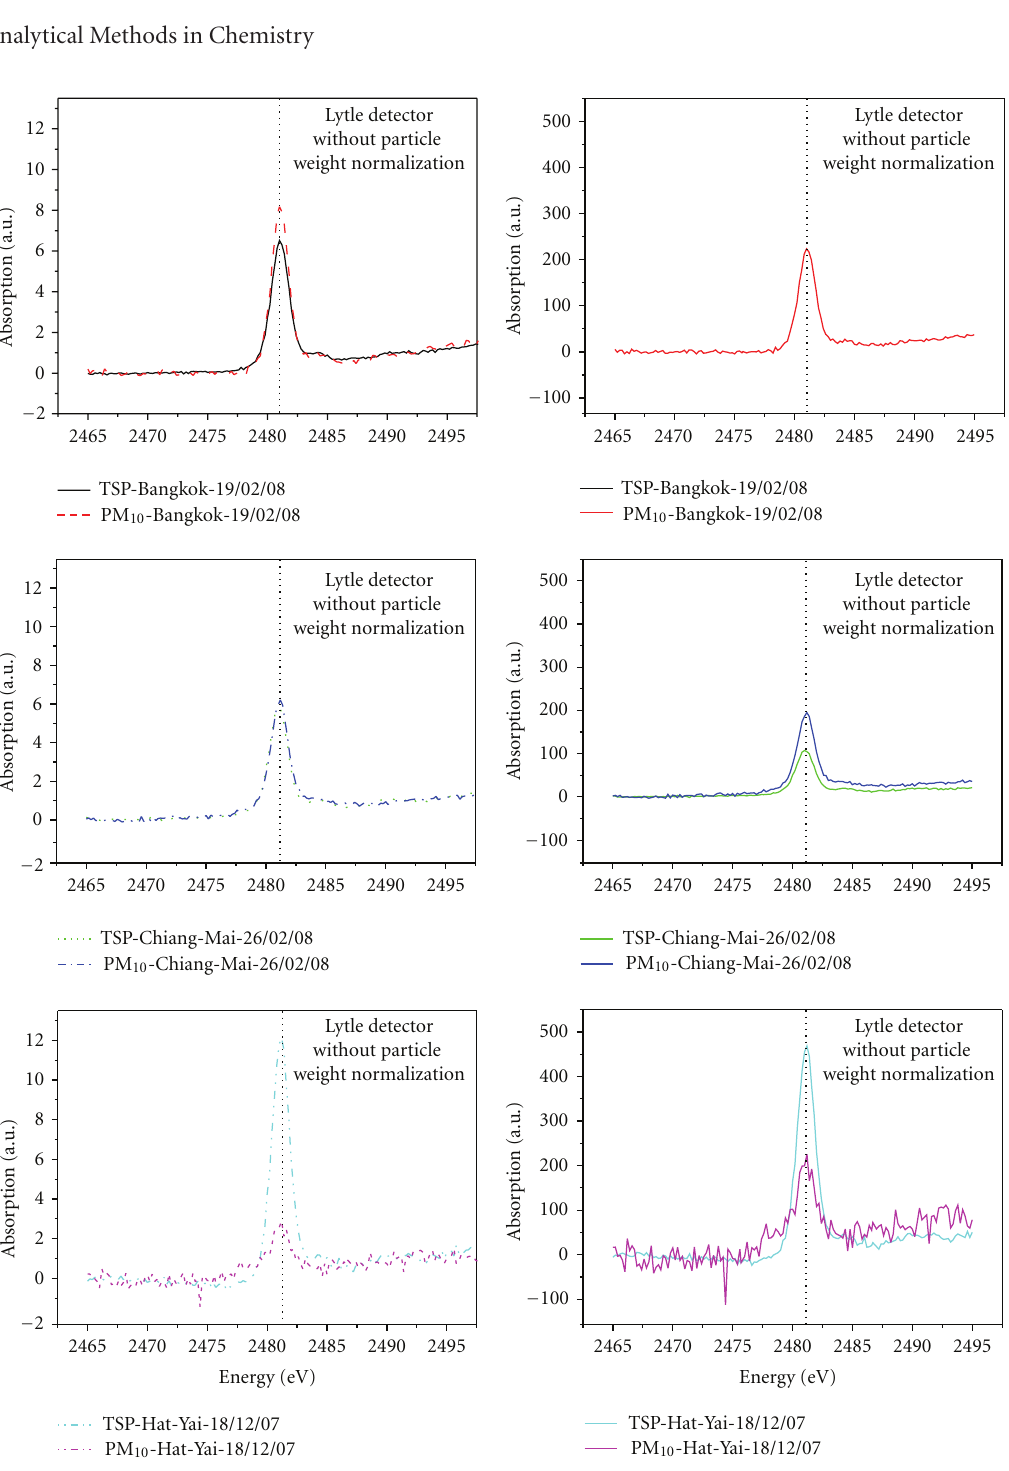
Figure 2: Comparison of sulfur K-edge XANES spectrum of urban aerosol collected at Bangkok, Chiang-Mai, and Hat-Yai measured by Lytle detector with and without particle weight